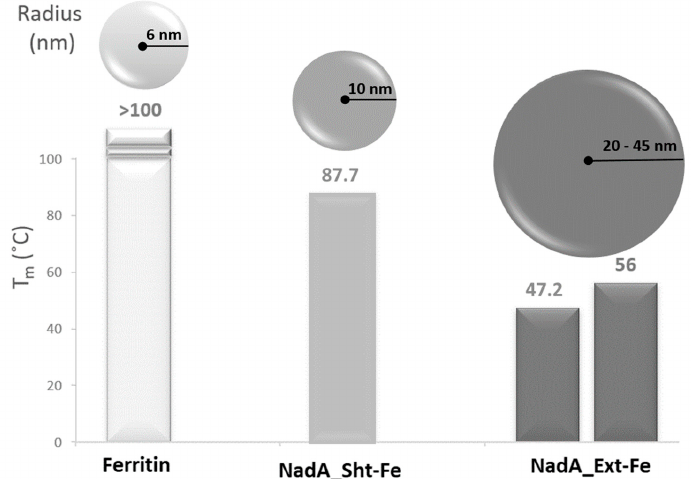
Figure 1. Size and thermostability of NadA-ferritin constructs. The sizes (radii) of the NadA-ferritin nanoparticles were estimated by Cryo-EM as described in the text. The NadA_Ext-Fe radius is shown as a range estimated from EM and the maximum theoretical in silico–predicted value (Figure S2). Melting temperatures (Tm °C) estimated by DSF are reported on top of the corresponding his-